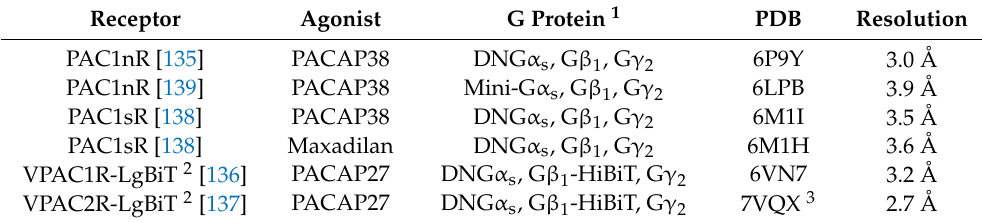
Table 6. Cryo-EM structures of active, peptide-bound, G s protein-coupled, PAC1R, VPAC1R, and VPAC2R as of June 2022. The PAC1R isoforms solved include PAC1R-null (PAC1nR) with the full-length ECD and PAC1R-short (PAC1sR) with the truncated N-terminal ECD. Receptor Agonist G Protein 1